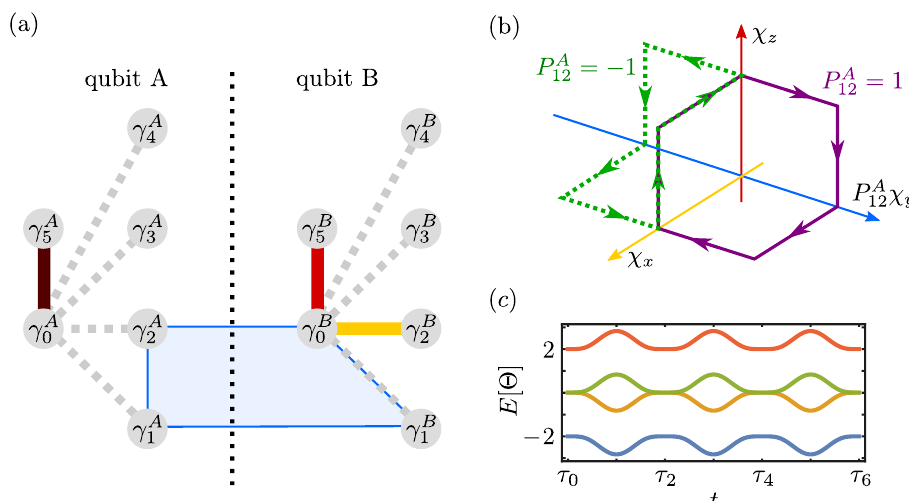
Figure 2: (a) Sketch of a two-qubit system consisting of 12 Majoranas. In the idle configuration, only the inter-qubit couplings P A and P B are non-vanishing and they 05 05 are represented with dark red and red lines, respectively. The 4 γ entangling protocol, described in Sec. 3.1, requires the control of the additional intra-qubit coupling P B 02 I (yellow line) and inter-qubit interaction I (blue area). (b) Intuitive understand- 11 20 ing of the effect of the inter-qubit interaction term: depending on the parity of the control MZM pair γ A and γ A , the holonomic protocol effectively corresponds either to 1 2 a clockwise (purple loop) or anticlockwise (green dotted loop) effective braiding of the target Majoranas γ B and γ B . (c) Spectrum of the Hamiltonian H 4 γ ( t ) along the 1 2 = Θ = Θ . closed loop Γ . Each line is 16-fold degenerate. Energies are in units of Θ x x We consider the six key configurations to be equally spaced in time, i.e. a constant τ − τ j + 1 j